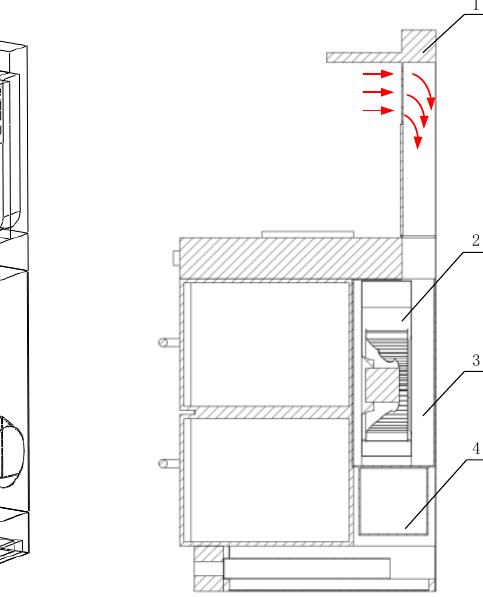
Table 1. Description of the key parameters of the integrated stove air duct